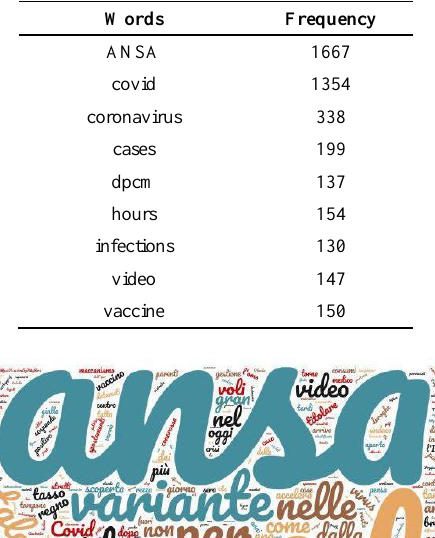
Table 9. Frequency of the most common words